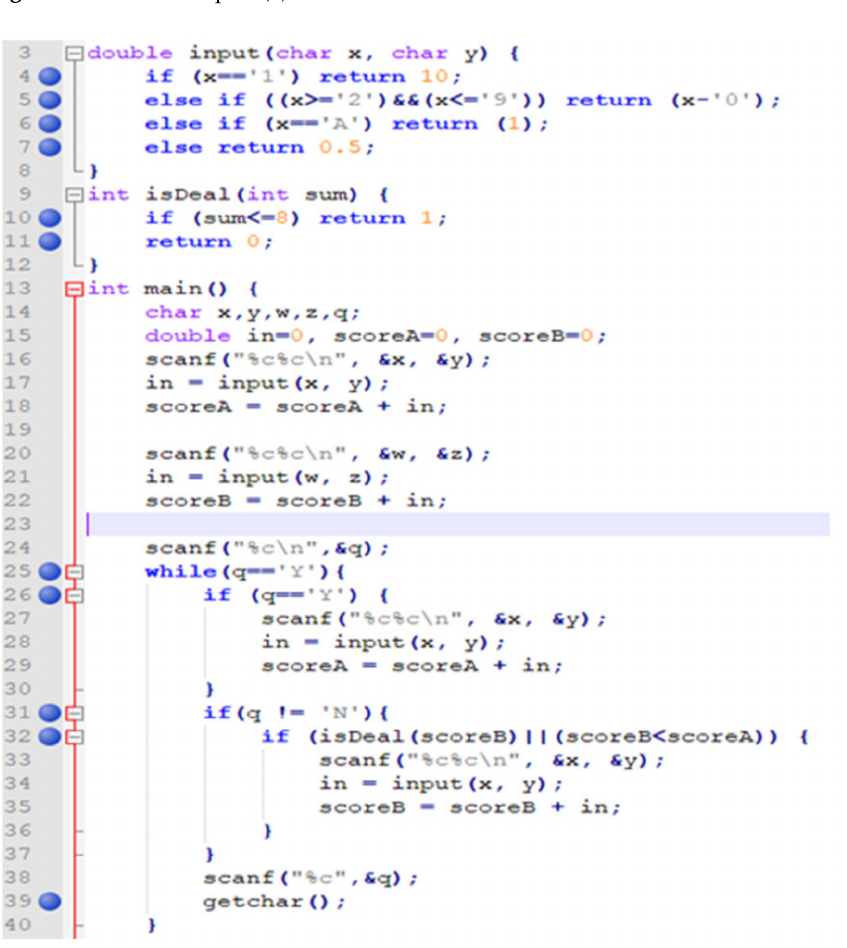
Figure 30. Feedback report (5).